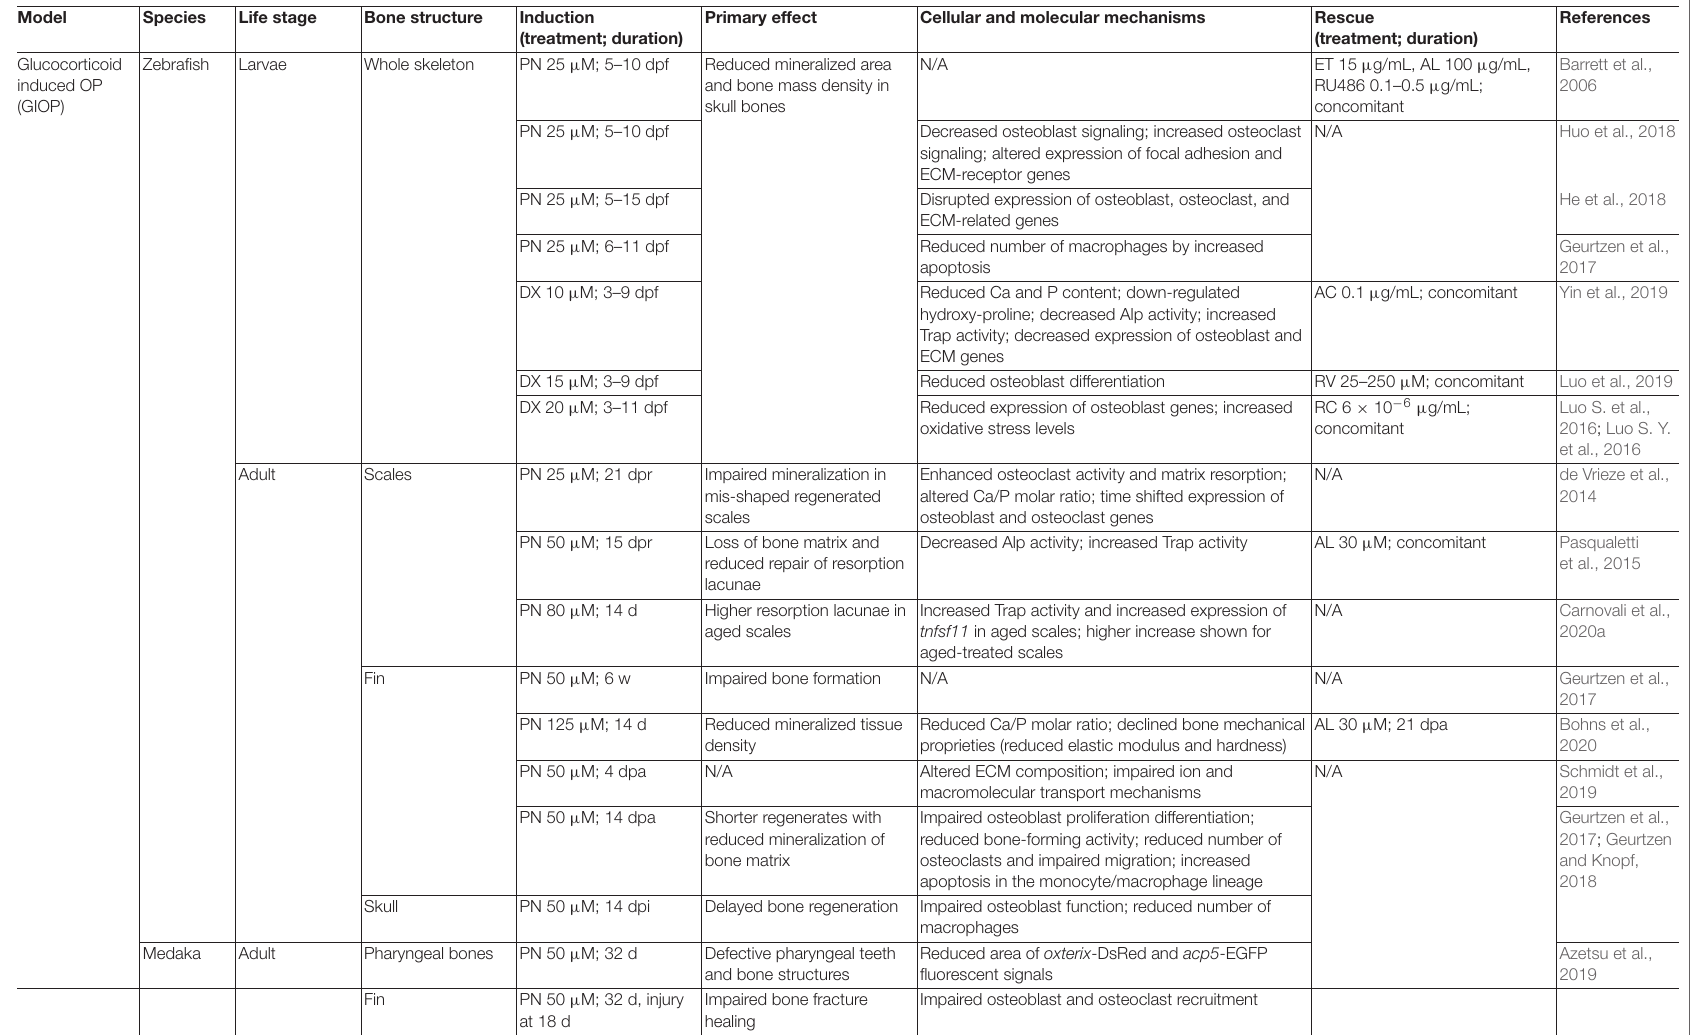
TABLE 1 | List of teleost models and respective assays to mimic mammalian osteopenic/osteoporotic phenotypes.